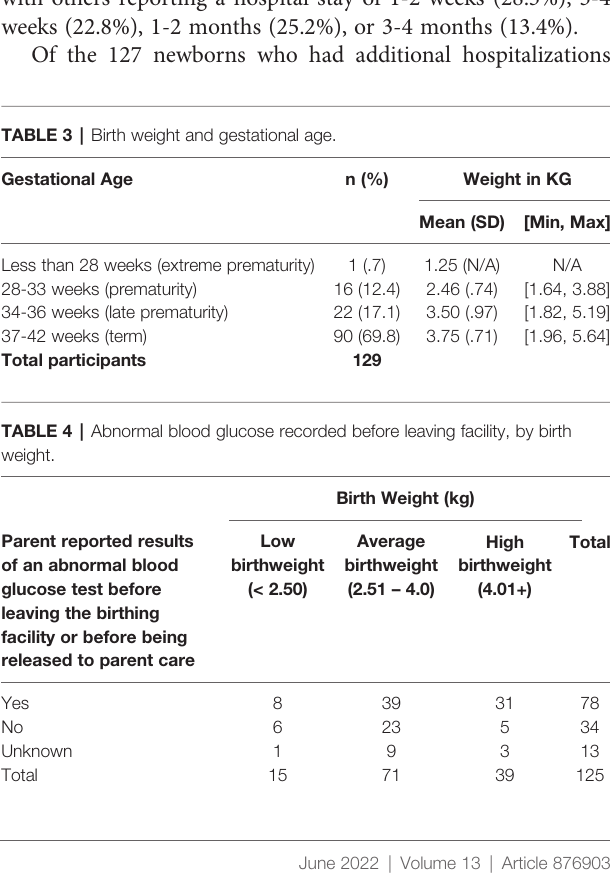
TABLE 1 | HI genetic testing results, by HI type.